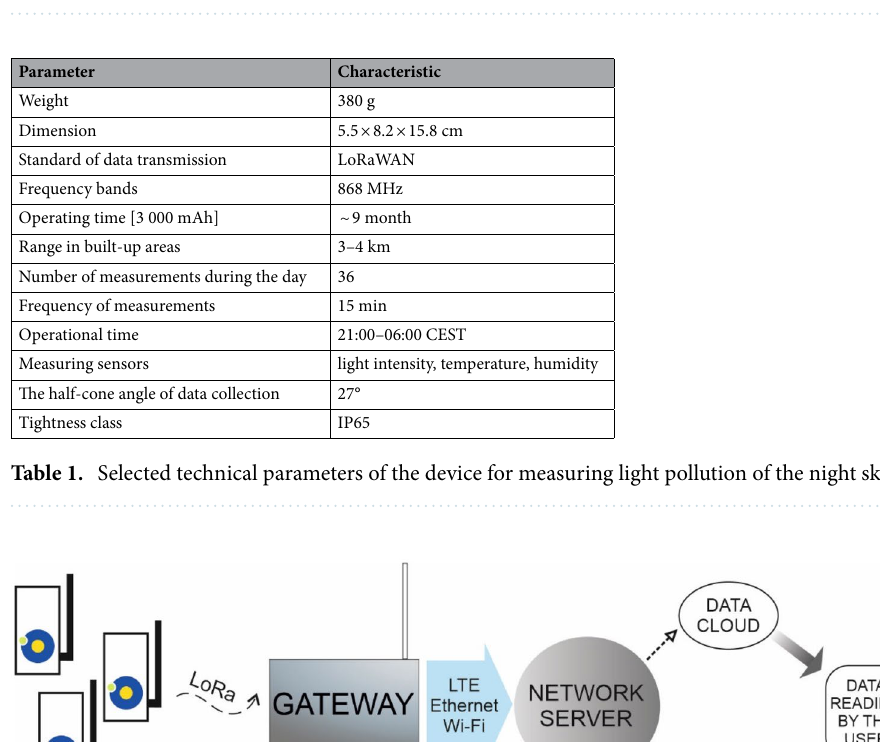
Figure 2. Constructed device view (photo by Dominika Karpińska).